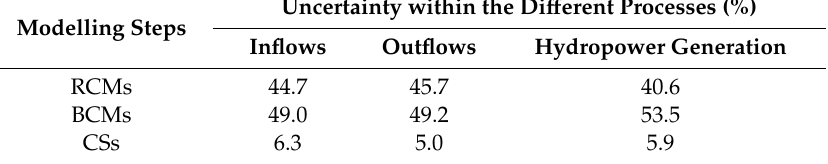
Table 4. The contribution of the di ff erent climate change impact assessment steps uncertainty (RCMs, BCMs, CSs) to the total uncertainty in the predicted inflows, outflows and hydropower generation of the Lim water system for the future period